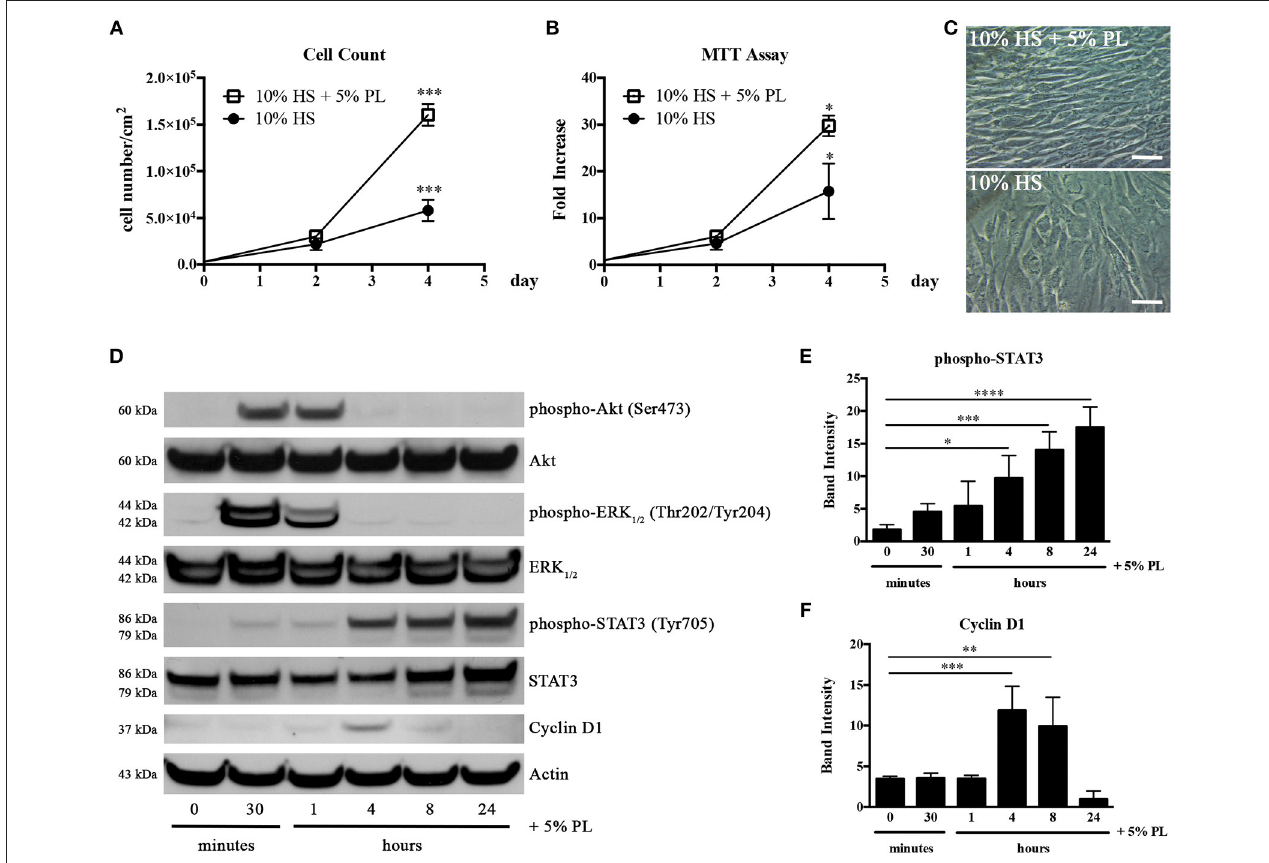
FIGURE 3 | Effect of PL on proliferation of HS-expanded hASC at passage 2. (A) Cell proliferation monitored by cell counting. Average values ± SD of 3 independent experiments, each one performed in duplicate, are reported. The *** symbol corresponds to p = 0.0004; (B) Cell viability evaluated by MTT assay and expressed as n-fold increase. Average values ± SD of 3 independent experiments, each one performed in triplicate, are reported. The * symbol corresponds to p = 0.02; (C) Morphology of PL-stimulated and un-stimulated cells after 4-day treatment (scale bars = 50 µ m); (D) Representative western blots of total protein content in lysates of hASC stimulated with PL, in the absence of HS, for different times. Primary antibodies were raised against phospho-Akt, Akt, phospho-ERK 1 / 2 , ERK 1 / 2 , phospho-STAT3, STAT3, Cyclin D1, and against Actin used as internal control; (E,F) Densitometric analyses (means ± SD) performed on 3 different phospho-STAT3- (E) and Cyclin D1-probed (F) western blots deriving from three independent experiments. The *, **, ***, and **** symbols refer to p = 0.02, p = 0.007, p ≤ 0.0009, and p < 0.0001,